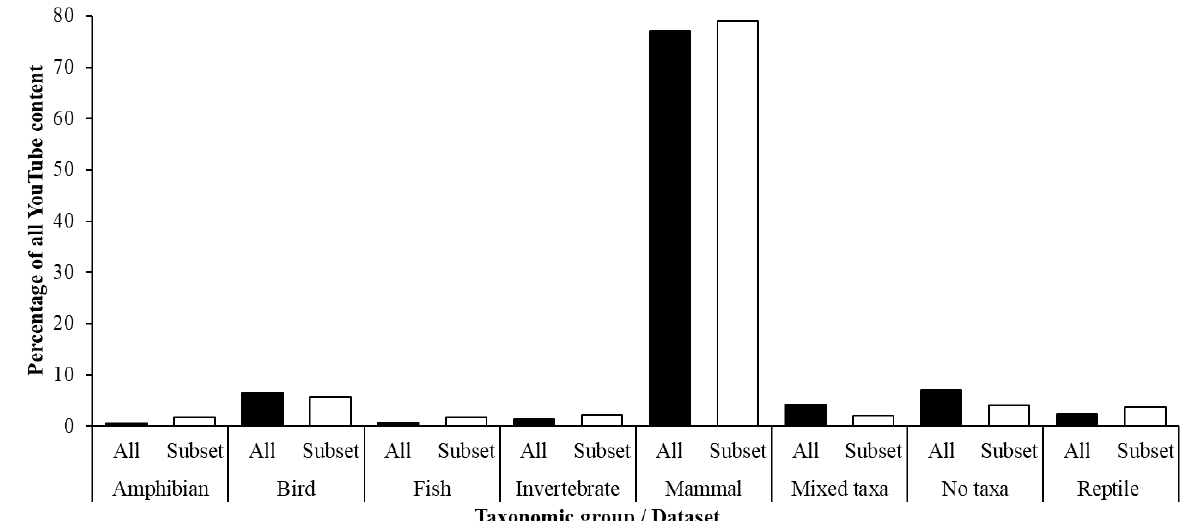
Figure 1. Taxonomic group representation, number of posts (as a percentage) for the sample (black) and subset of zoos each main taxonomic group for all 20 zoos (black) and the subset of three zoos (white-most popular posts only). A significant difference is evident between the number of postings from each zoo on mammals compared to other taxonomic groups and types of post ( χ 2 = 3862.7; N = 1000; df = 7; p < 0.001). Excluding YouTube content that was not animal-focused and